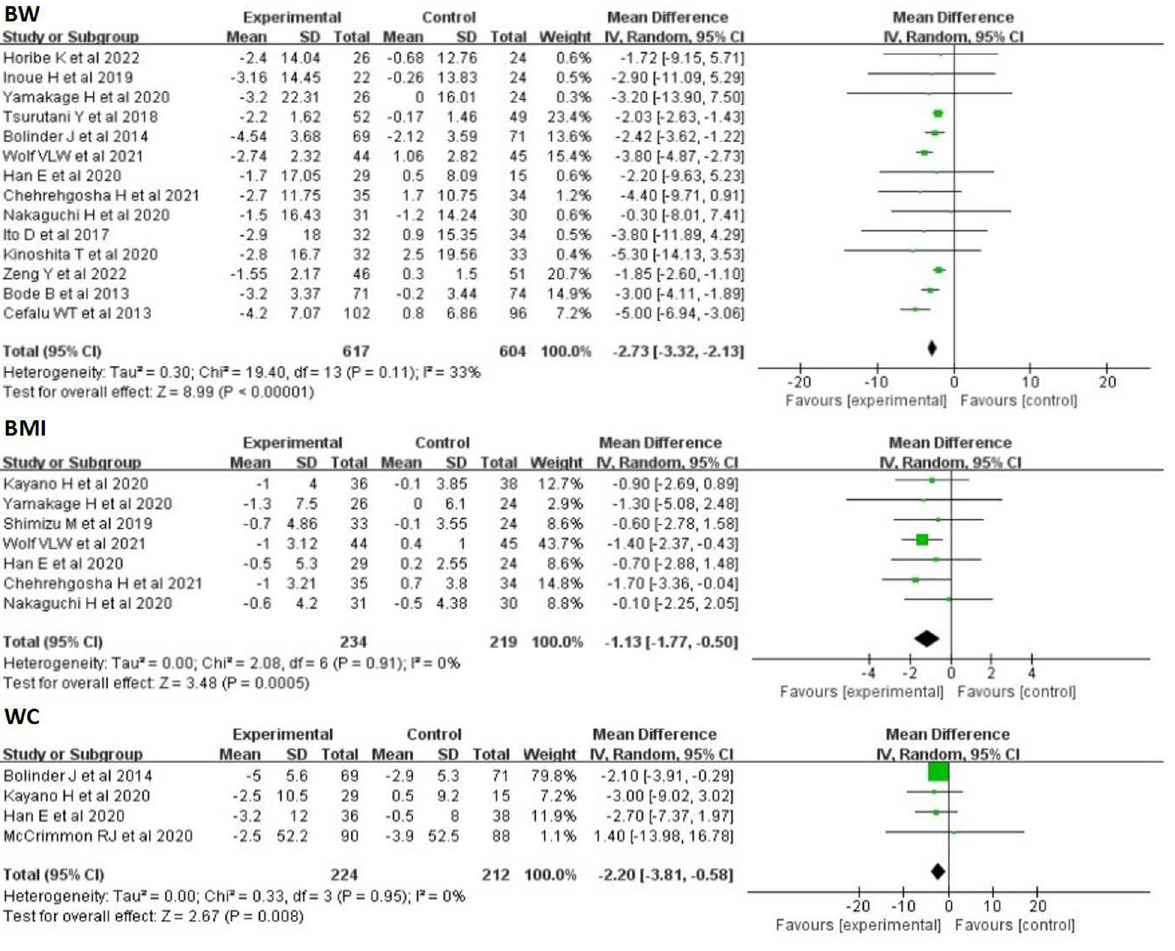
Fig 2. Forest plots depicting BW, BMI and WC comparisons between SGLT-2 inhibitors and the control group.